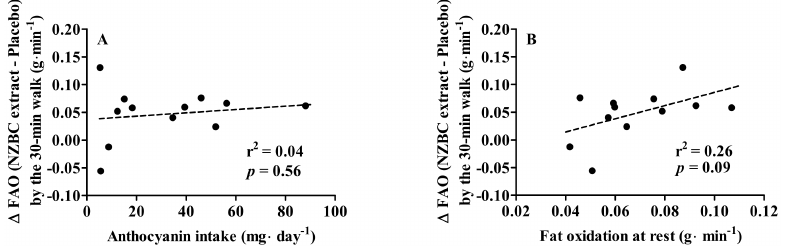
Figure 2. Relationship between habitual anthocyanin intake ( A ) and fat oxidation at rest ( B ) and the changes in fat oxidation ( ∆ FAO) by 30 min of moderate-intensity treadmill walking with intake of New Zealand blackcurrant (NZBC) extract. The ∆ FAO is the fat oxidation with intake of New Zealand blackcurrant extract minus the fat oxidation with intake of placebo. The habitual anthocyanin intake did not include the anthocyanin intake by New Zealand blackcurrant extract. The dotted lines are the linear regression lines.